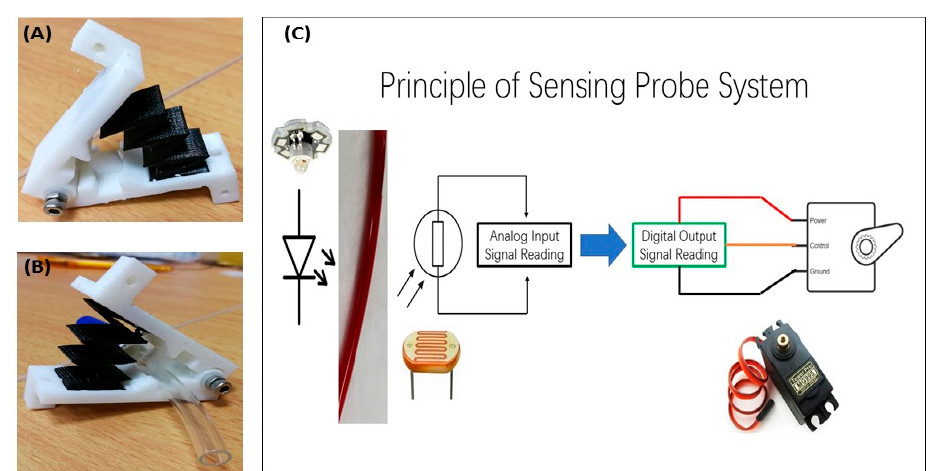
Figure 2. The saline drip control system. The gripper mechanical gripper ( A ) controls the saline drip flow by jamming the saline tube ( B ). The gripper is controlled using the servo motor. By detecting the amount of light received by the Light Dependent Resistor(LDR), the servo motor actuates to a specified angular position ( C ).